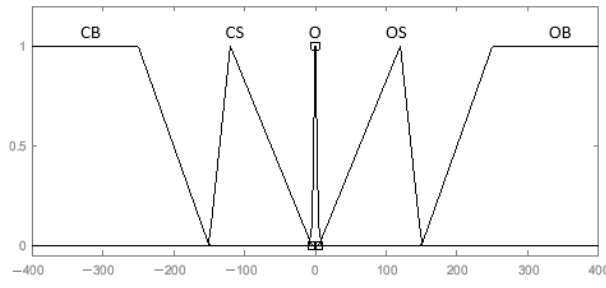
Figure 6. Membership functions for output.